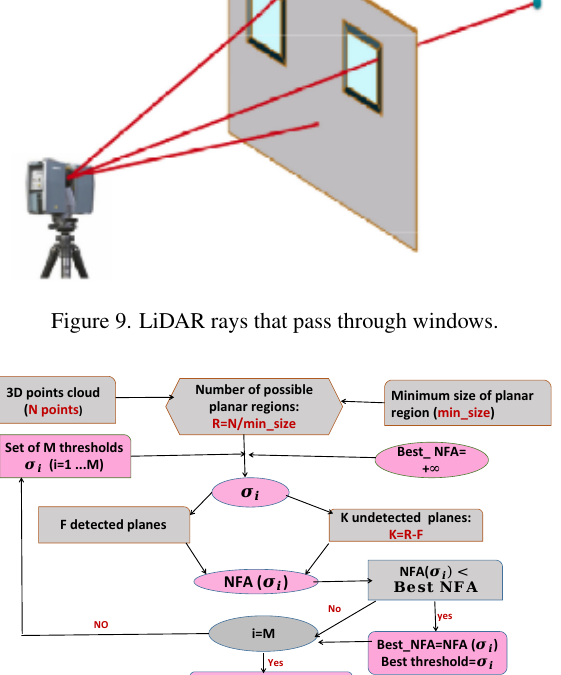
Figure 10. Design of the contrario validation method. fac¸ades, leading to a bad detection of interior points. In order to select automatically an appropriate threshold, we propose an a contrario algorithm that takes as input M possible thresholds and selects the threshold with the lowest NFA (Number of False Alarms). Given a 3D point cloud of N points, the definition of the minimum size min size of a planar region allows us to deduce the maximum number of possible planar